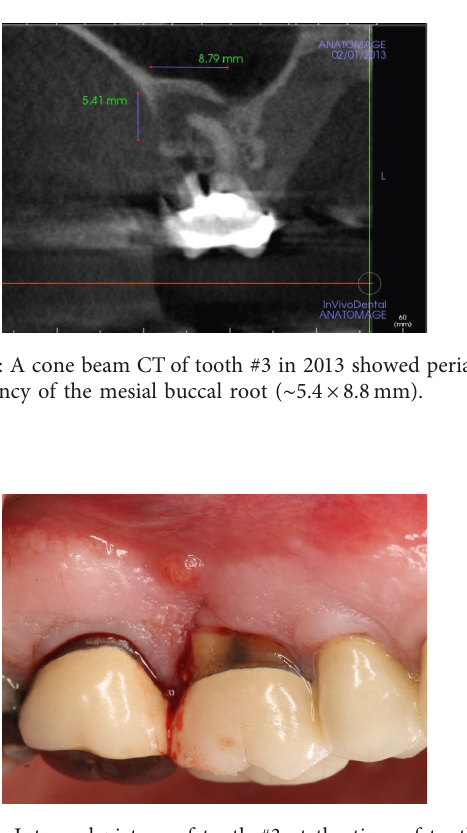
Figure 3: Intraoral picture of tooth #3 at the time of tooth ex- traction. A draining fistula was noted on the distal surface of